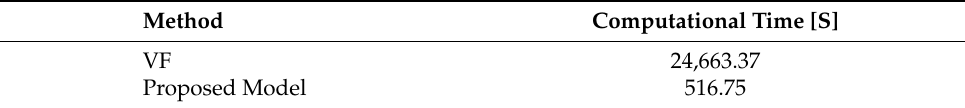
Table 12. Computational